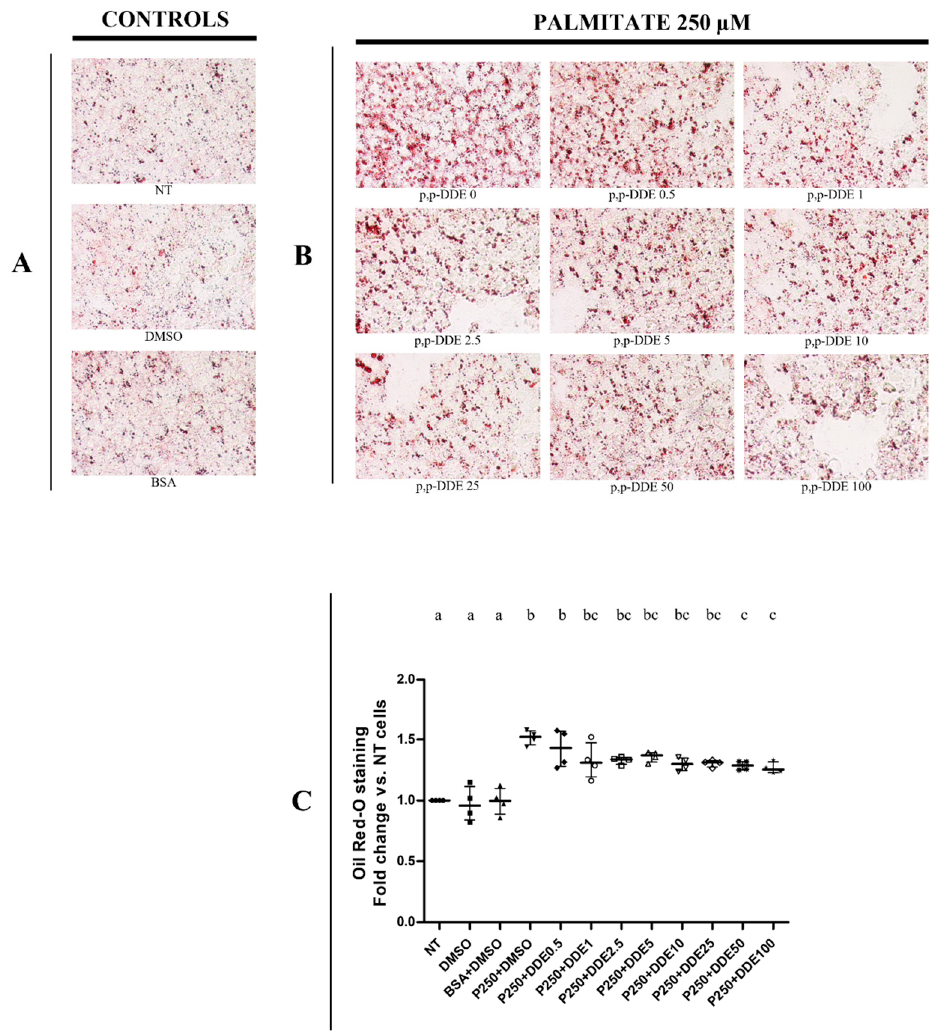
Figure 3. Total lipid content in response to different doses of DDE co-incubated with palmitate. ( A ) representative images of lipid depots in control cells (NT, DMSO, BSA); ( B ) representative images of cells treated with palmitate or with palmitate and increasing DDE doses. Original image magnification used: 40×. Quantitative analyses were obtained quantifying oil Red-O accumulation in cells. Oil-Red O quantifications were measured spectrophotometrically (490 nm). Data graphically represented as median with interquartile of range for 4 biological replicates ( C ). Three different control groups of cells were tested (non-treated cells, NT; DMSO and BSA) to evaluate the specific effect of DDE on fatty acid deposition. Statistical analyses were performed by using GraphPad Prism software. One-way ANOVA analysis followed by Bonferroni’s post-hoc test: different letters indicate statistically different values.